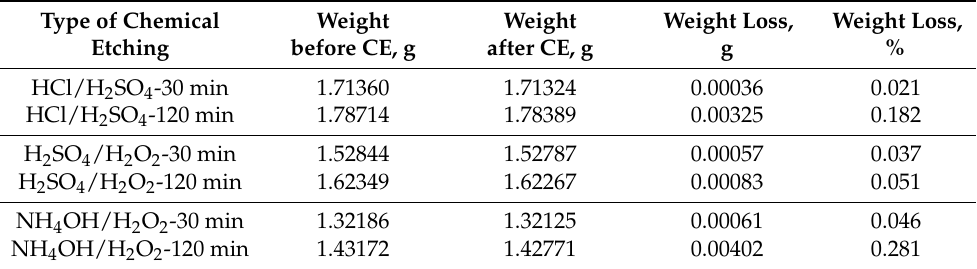
Table 1. Weight loss of chemically etched